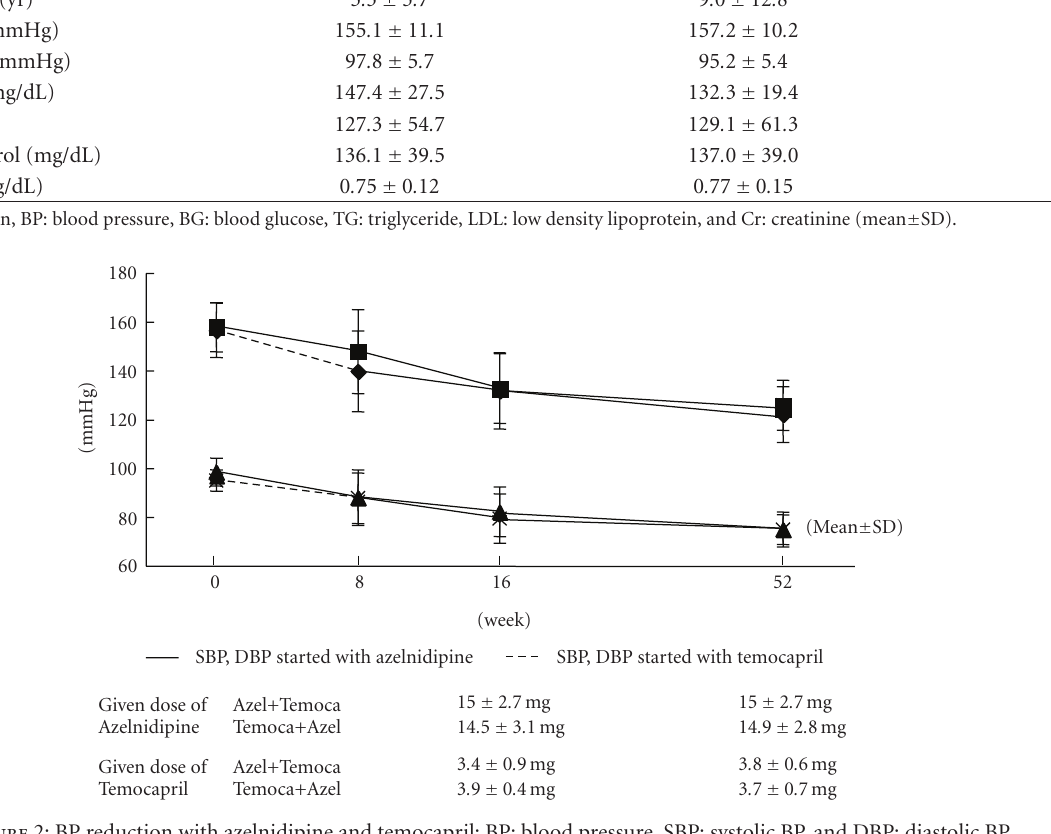
signaling cascades initiated by G-protein-coupled receptors (GPCRs) activation [21]. RGS proteins facilitate the intrinsic inactivating guanosine triphosphatase reaction of